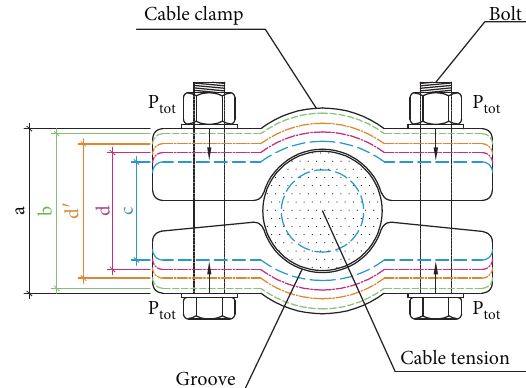
Figure 19: Deformation and rebound of a clamp